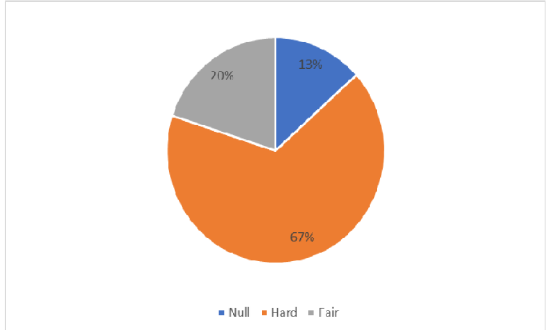
Figure 3. Students’ opinion about the degree of effort with the activity